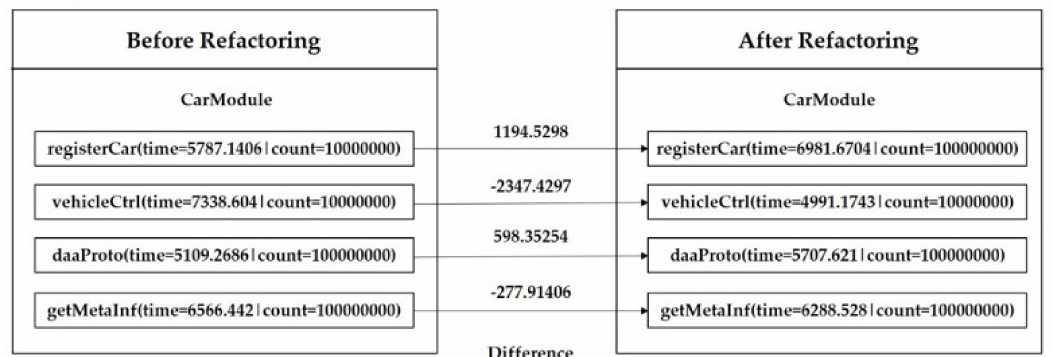
Figure 19. Detailed class view with performance indicators on